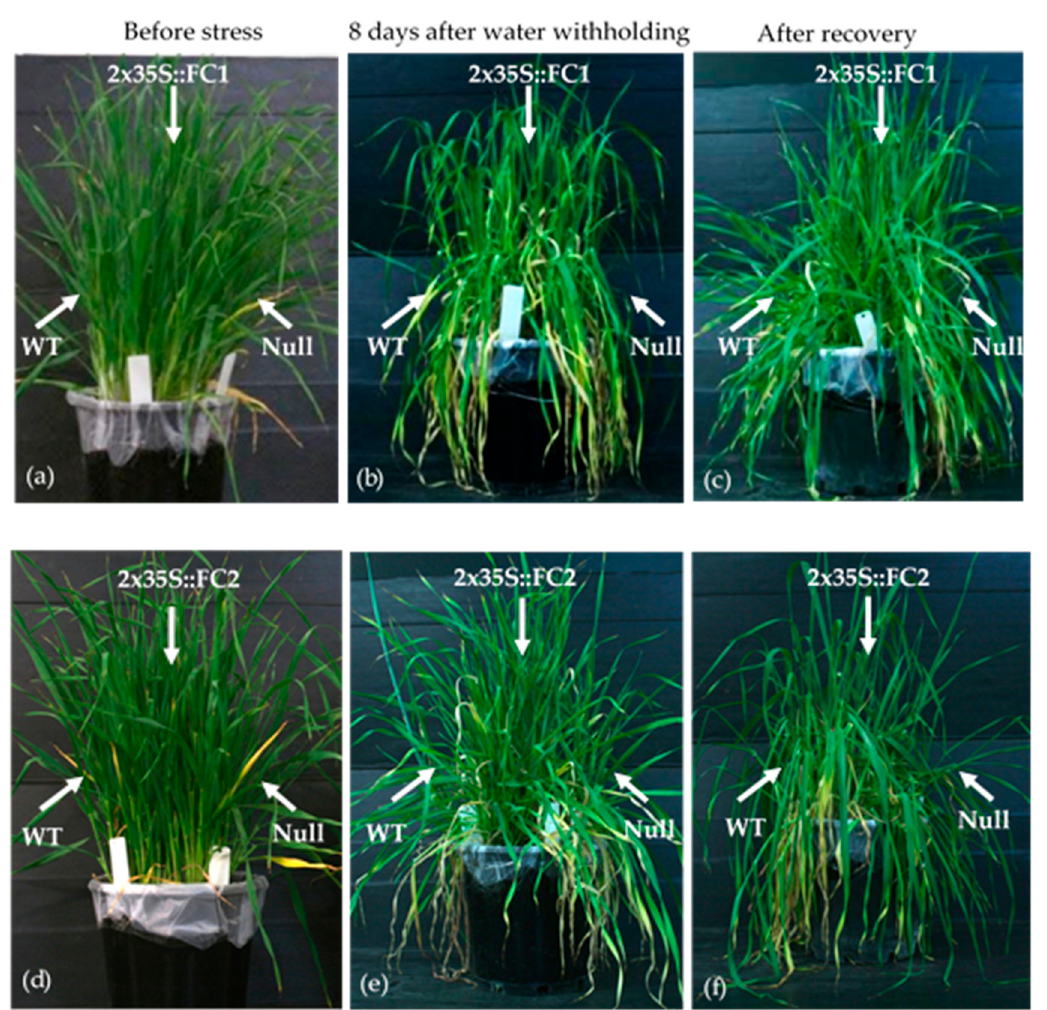
Figure 3. Phenotypes of the representative control plants and transgenic lines (T 2 ) grown under controlled environmental conditions in the absence of stress ( a , d ), 8 days post water-withholding ( b , e ), and after re-watering ( c , f ). The control plants were reversibly wilted, 8 days after withholding water, whereas both types of transgenics did not wilt.